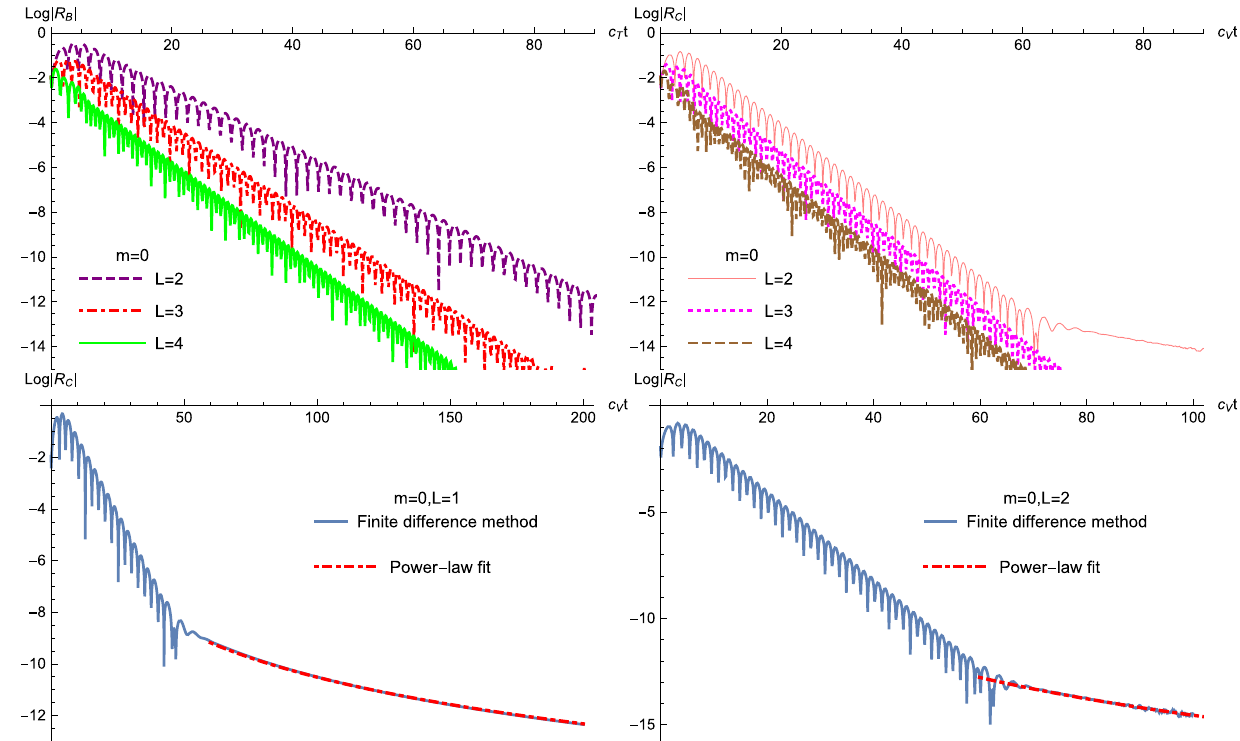
Fig. 3 The time profiles of axial gravitational quasinormal modes for R B and R C for the metric parameter m = 0. Bottom row: close-ups on the æther late-time tails together with the numerical fits in accordance to the respective power-law forms t − ( 2 L + 4